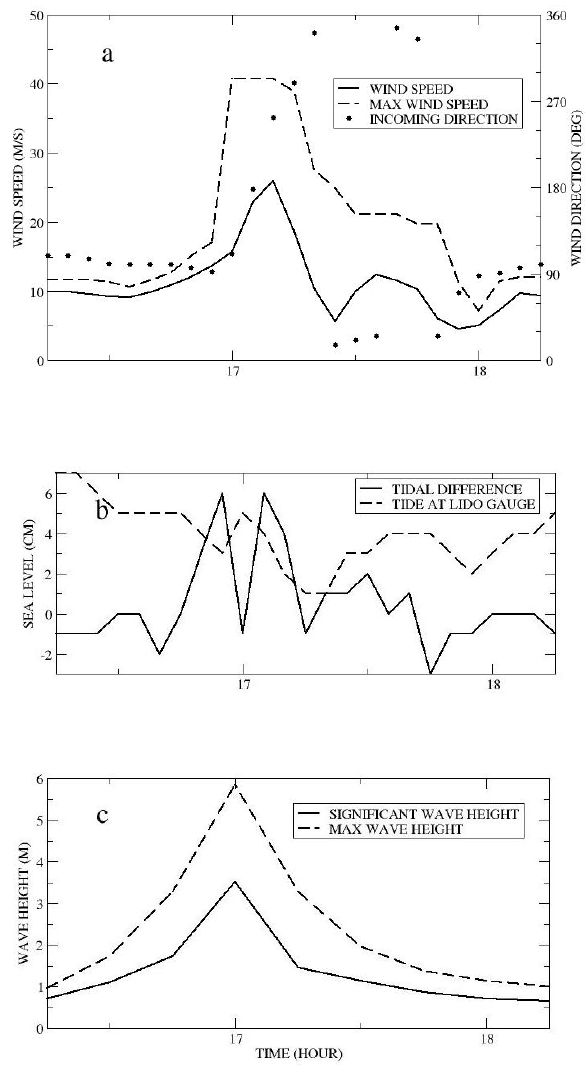
Fig. 6. Time history of (a) the mean and maximum wind speeds and related directions during consecutive five minute records at the ISMAR oceanographic tower (see Fig. 2 for its position). (b) Sea Figure 6 – Time history of a) the mean and maximum wind speeds and related directions during level difference between the ISMAR oceanographic tower and the consecutive five minute records at the ISMAR oceanographic tower (see Figure 2 for its position). tide gauge at the Lido exit of the Venice lagoon (see Fig. 2 for their b) Sea level difference between the ISMAR oceanographic tower and the tide gauge at the Lido exit position). The second line shows the tide history at Lido (an ar- of the Venice lagoon (see Figure 2 for their position). The second line shows the tide history at Lido bitrary zero has been used). (c) Significant and maximum wave (an arbitrary zero has been used). c) Significant and maximum wave heights during consecutive 3 heights during consecutive 3min records at 15min intervals Time min records at 15 minute intervals Time UTC.